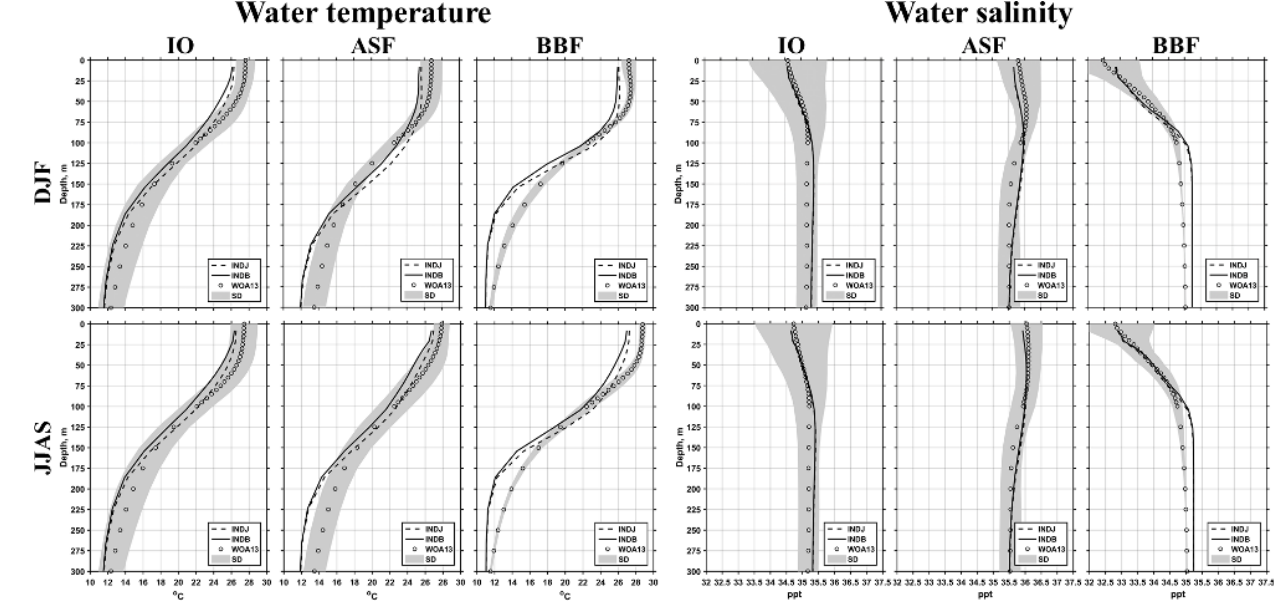
Figure 6. Vertical profiles of water temperature and salinity time-averaged seasonally (DJF, JJAS) for the period 1975–2004. INDJ and INDB designate the model runs. WOA13 designates the climatic data from the World Ocean Atlas 2013 (Locarnini et al., 2013; Zweng et al., 2013). SD designates the standard deviation of the WOA13 data.